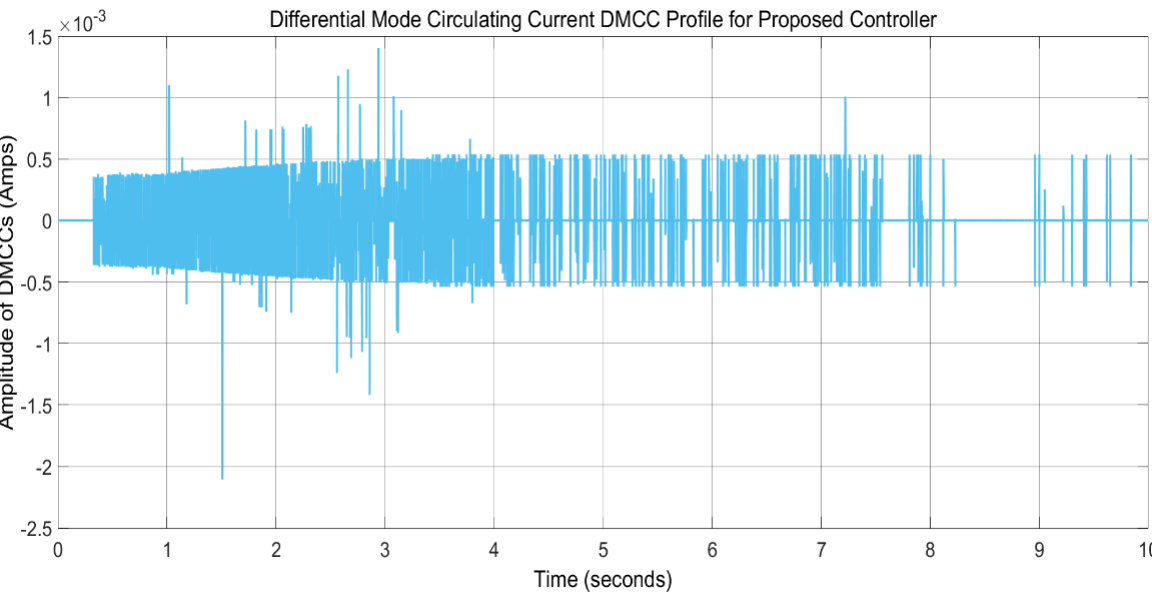
Figure 21. THD profile for AICMC controller case.